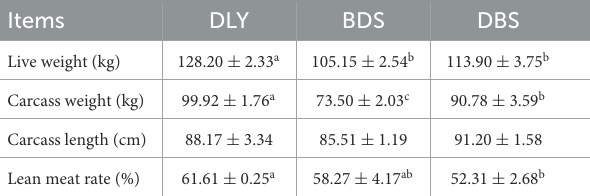
TABLE 2 Comparison of meat quality characteristics among DLY, BDS, and DBS.